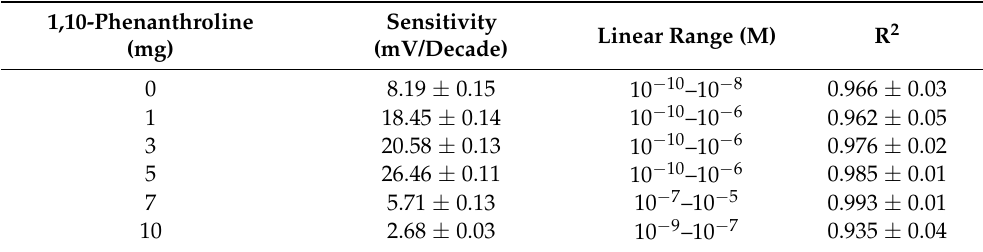
Table 1. Sensitivity and linear range profiles of Pb 2+ ISE against the weight variation of 1,10- phenanthroline.